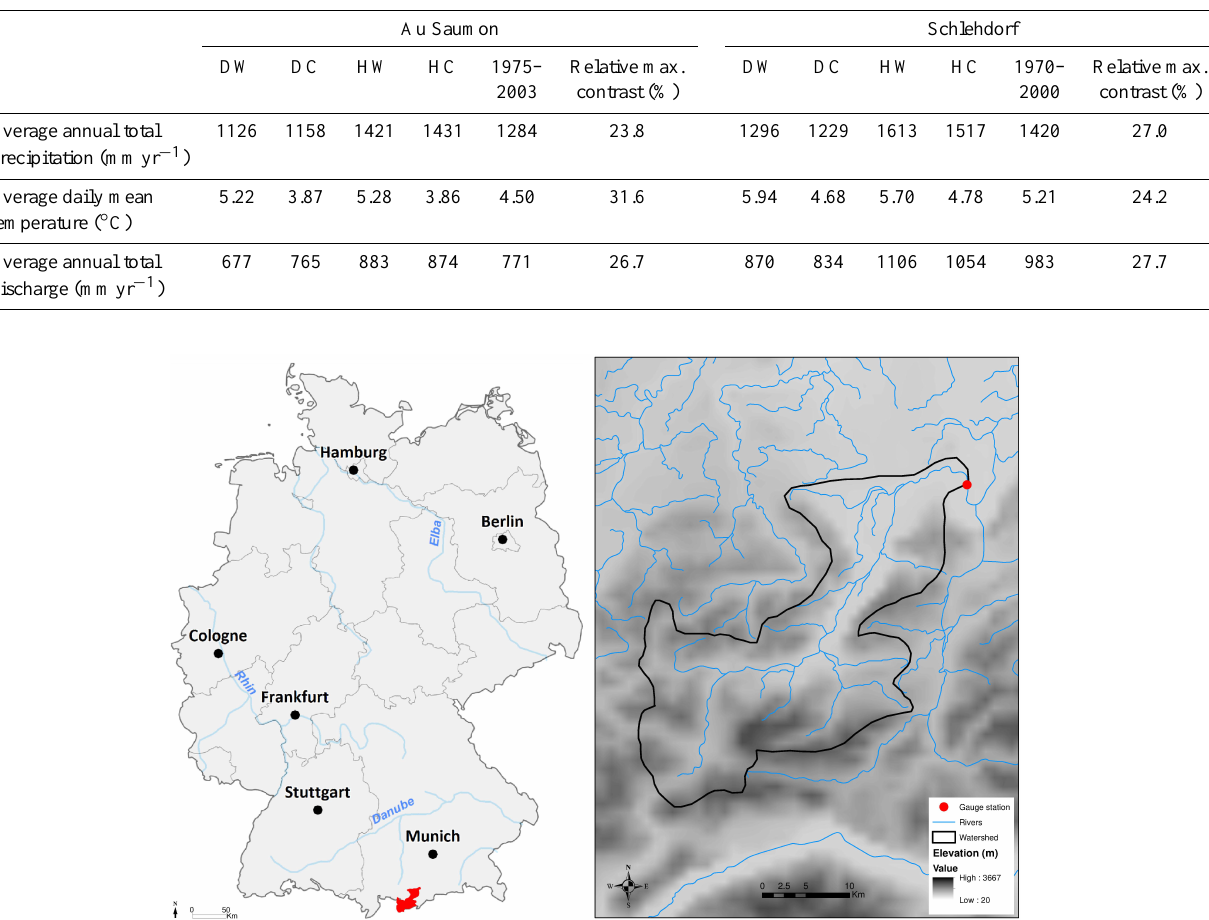
Table 1. Main characteristics of the periods selected for the DSST on the Au Saumon and Schlehdorf catchments (DW: dry/warm; DC: dry/cold; HW: humid/warm; HC: humid/cold) and relative maximum contrast between periods (computed as the ratio of the difference between maximum and minimum value over the four periods and the mean value over the whole record).